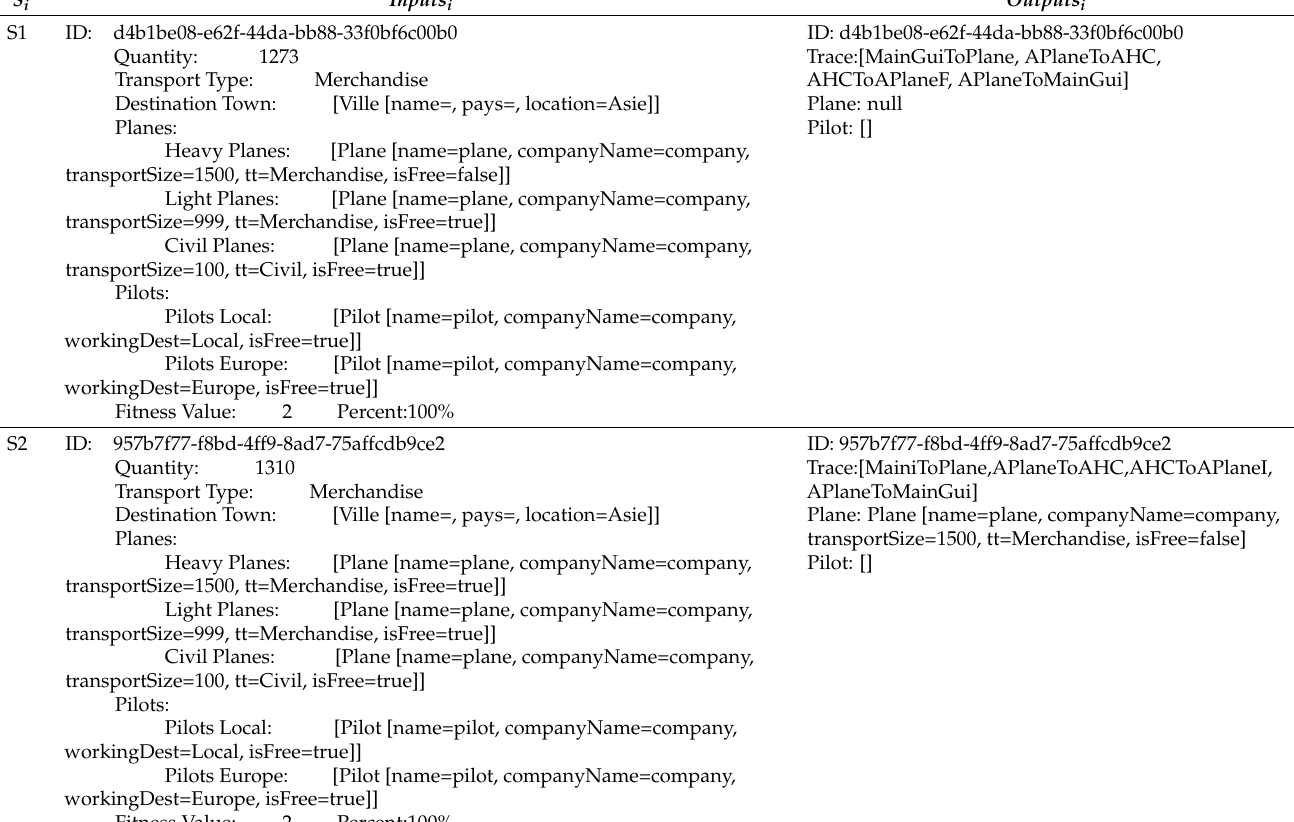
Table 3. Results of the generation of test cases ( inputs and expected outputs ) obtained for some scenarios